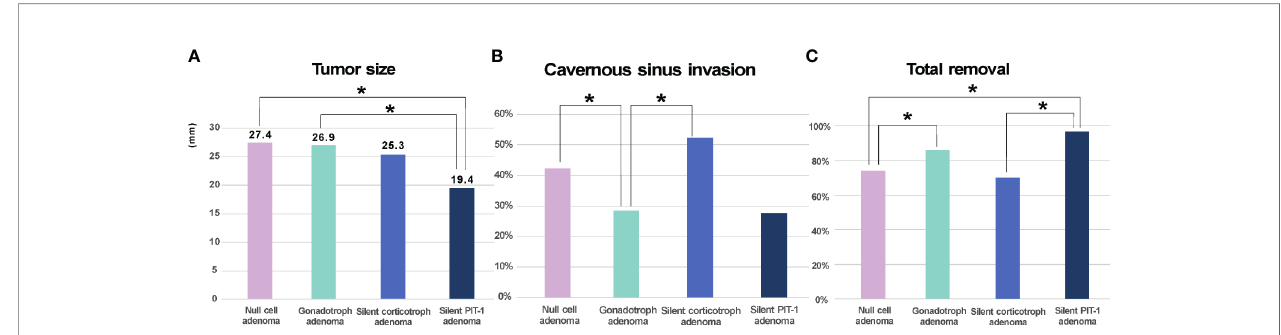
FIGURE 4 | Clinical characteristics of endocrine-inactive tumors. (A) . Null cell adenomas and gonadotroph adenomas did not differ in size whereas silent PIT-1 adenomas were the smallest. (B, C) . Null cell adenomas showed more frequent cavernous sinus invasion than gonadotroph adenomas, which makes total removal loss feasible in patient with null cell adenomas. The incidence of cavernous sinus invasion was the highest in silent corticotroph adenoma. On the contrary, patients with gonadotroph adenomas were less likely to have cavernous sinus invasion. Among 29 patients with silent PIT-1 adenomas, 28 patients underwent total removal, which was signi fi cantly higher than patients with null cell adenomas or silent corticotroph adenomas. Cavernous sinus invasion was identi fi ed by preoperative magnetic resonance imaging and based on surgeon ’ s inspection intraoperatively. PIT-1, pituitary speci fi c transcription factor 1; * P <